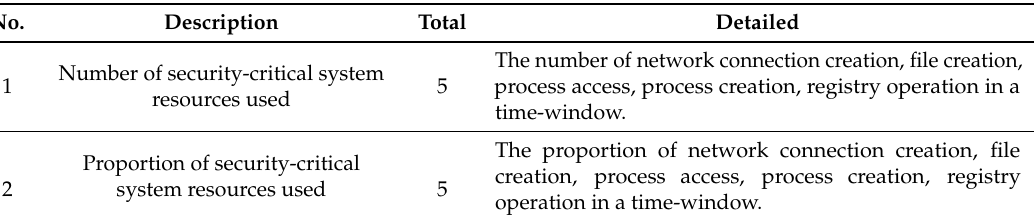
Table 1. Detail of host-side features.